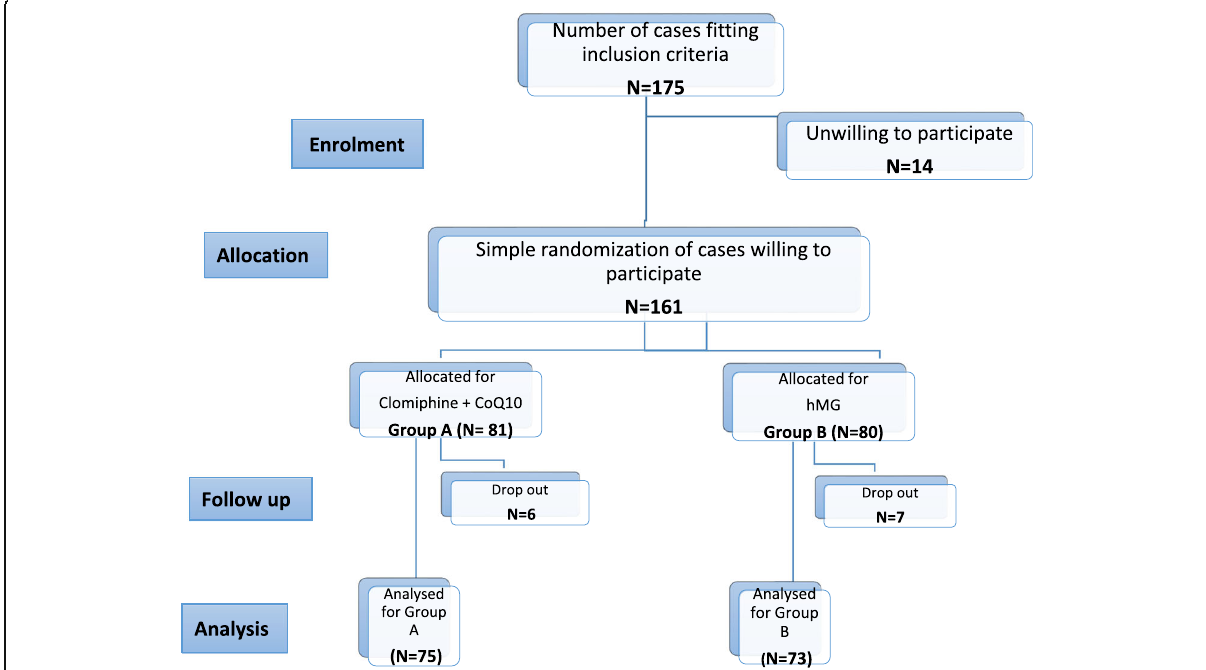
Fig. 1 Flowchart of the study population